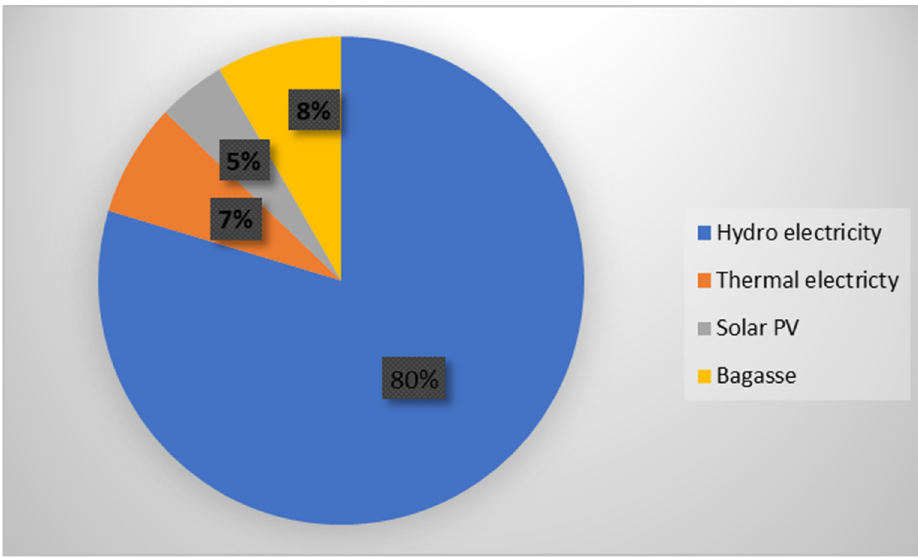
Figure 1. Current operational electricity capacity in Uganda (own analysis: data from ERA 2022 [15]. Charcoal is used for cooking among the town populations, while firewood for the rural population [9,23]. The high demand for uneconomical wood fuels results in the misuse and exhaustion of forests [9,10,21,22]. Even though there are numerous drivers of deforestation, wood fuel and demand play a significant role in the trend (Figures 2 and 3). Moreover, illegal logging has increased amidst the forest conservation laws coupled with weak implementation by the authorities [9,24].